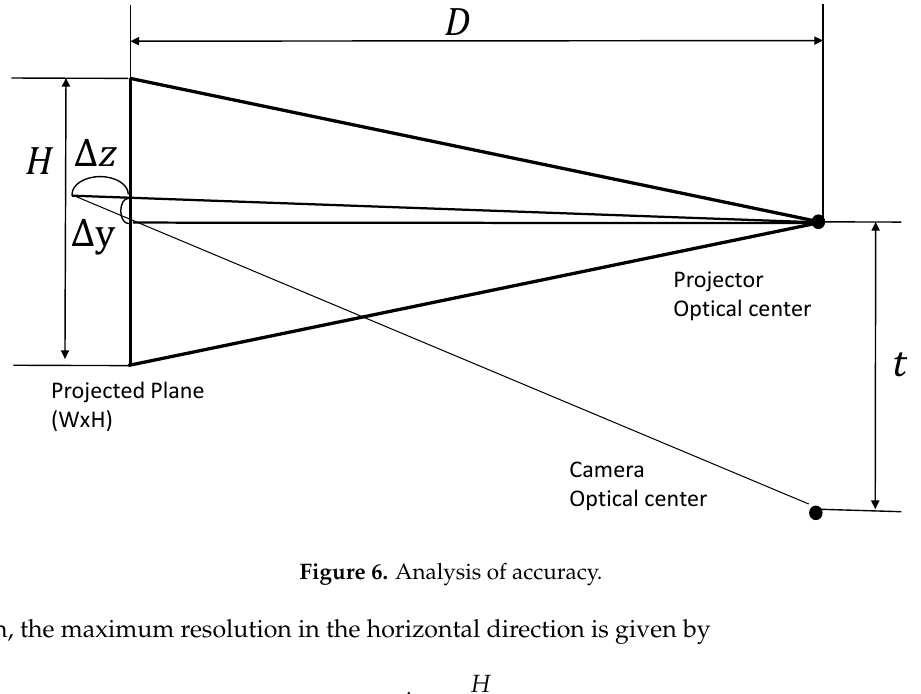
Figure 6. Analysis of